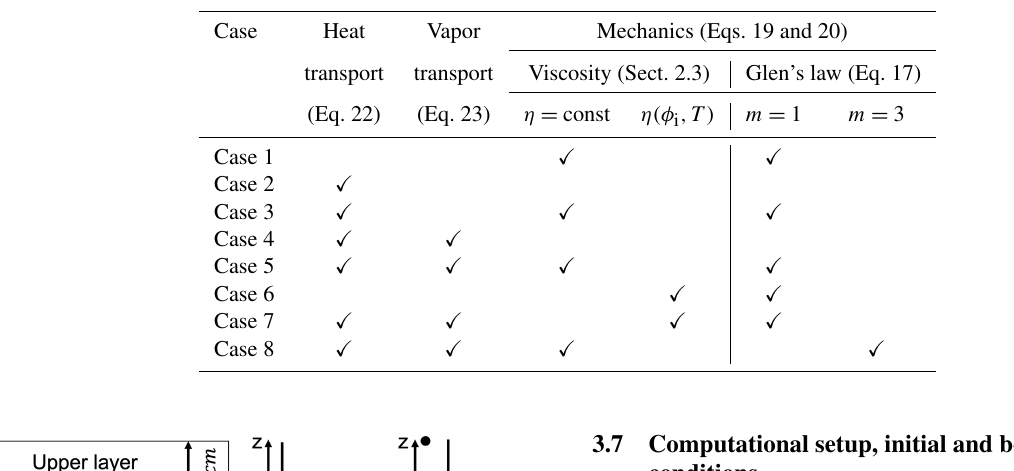
Table 2. List of the various simulation scenarios, referred to as cases , in which we activate different combinations of process building blocks and consider constant-viscosity and non-constant-viscosity closures. Heat transport induces vapor transport and triggers phase changes. Cases 5, 7 and 8 are also referred to as fully coupled processes .